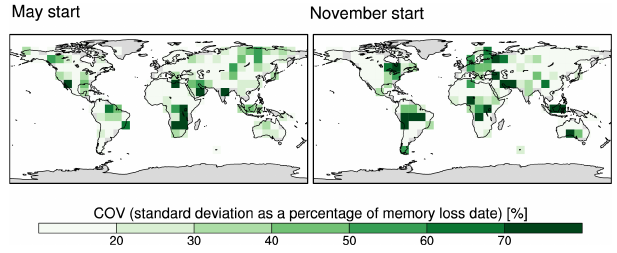
Figure 4. Sensitivity of memory to hydraulic parameters (standard deviation of memory loss across hydraulic parameters as a percent- age of the memory loss) in the top model soil level, estimated from H-TESSEL, for May (left) and November (right) start